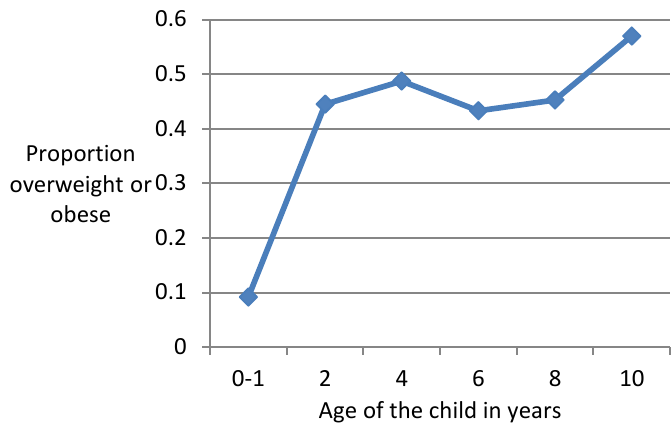
Figure 3. Plot of proportion of overweight or obese children against age of the children (in years).